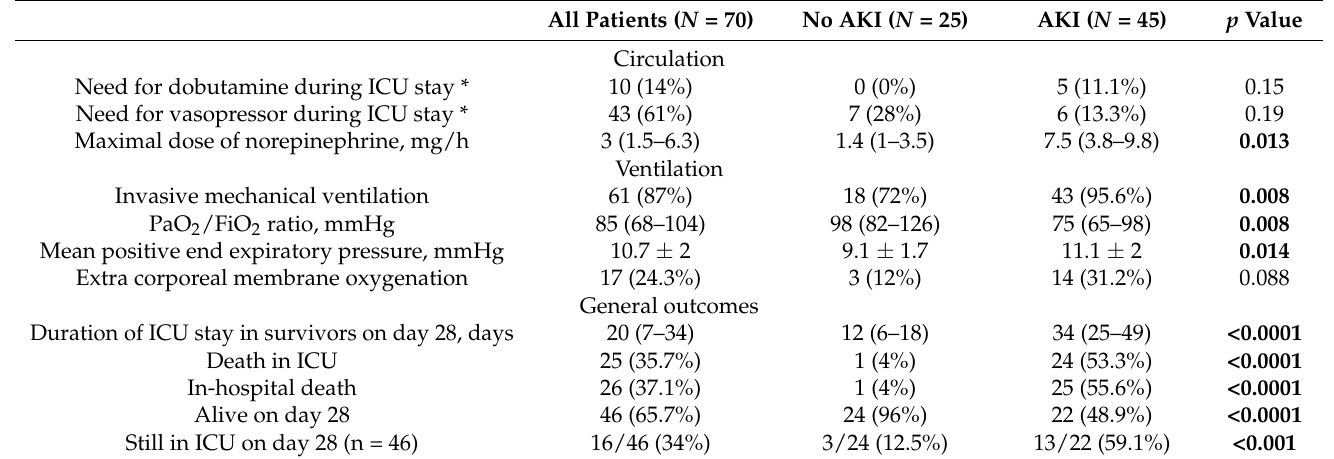
Table 3. Outcomes of critically-ill COVID-19 patients according to the occurrence of acute kidney injury